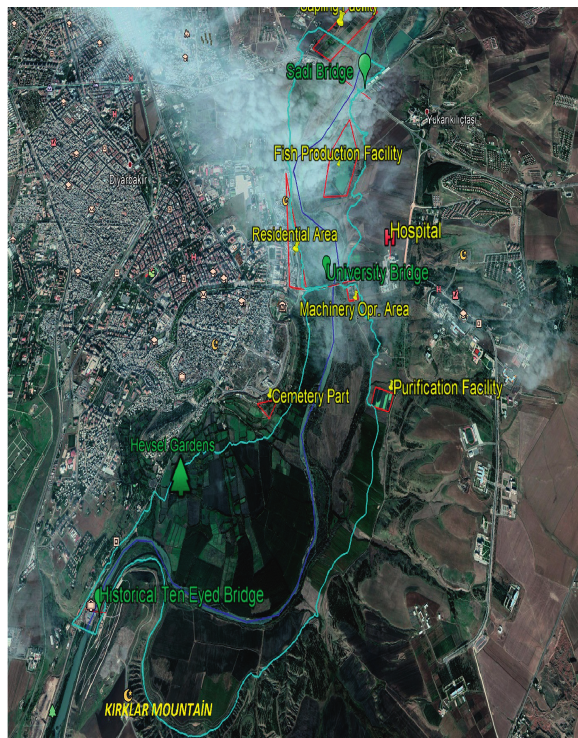
Figure 8: Flood boundary with HEC-RAS ( Q